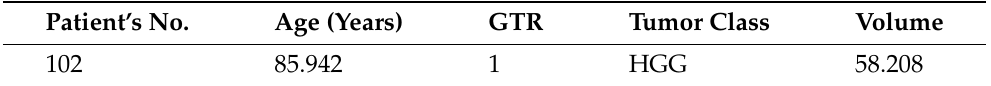
Table 8. Single Patient input